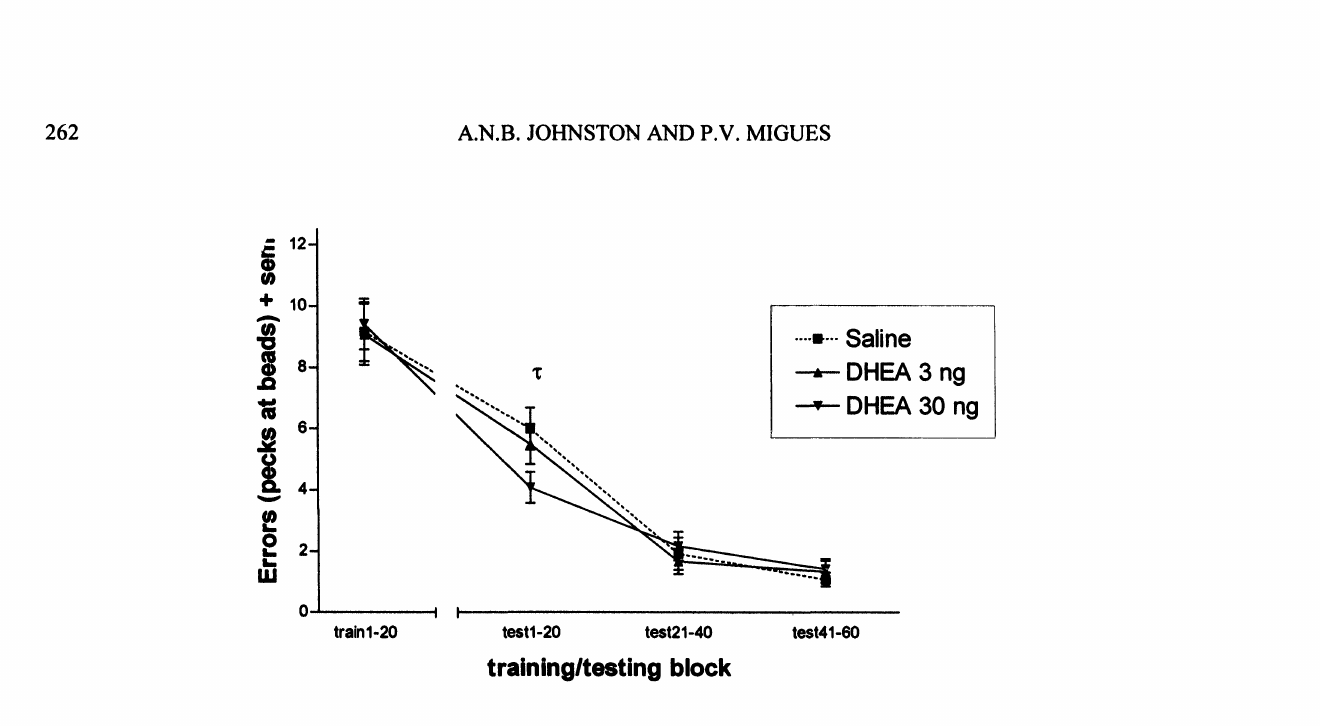
Fig. 2: Effects of a bilateral injection of DHEA (3 or 30 ng in saline; upright or inverted triangles) or saline (squares) into the IMHV 5 min before training on the pecking accuracy of chicks during both training and testing. Data are analysed and presented as errors (pecks at beads) in each block of 20 pecks, x indicates a trend towards statistical difference from the internal, saline- injected, control group and 3 ng DHEA-treated group, 0.10 > P > 0.05. n 12 for each